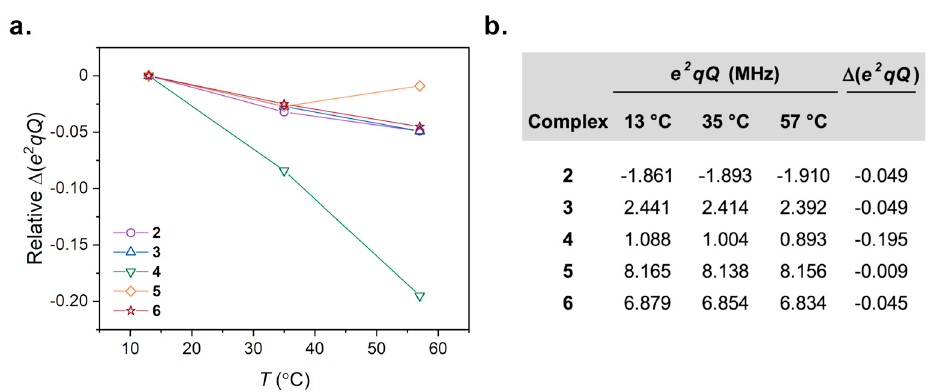
Figure 4. ( a ) Trends in predicted quadrupolar coupling parameters, e 2 qQ, from variable-temperature predicted structures of 2 – 6 . ( b ) Temperature-specific quadrupolar coupling parameters at each temperature-specific structure and Δ e 2 qQ over the ~50 °C range.